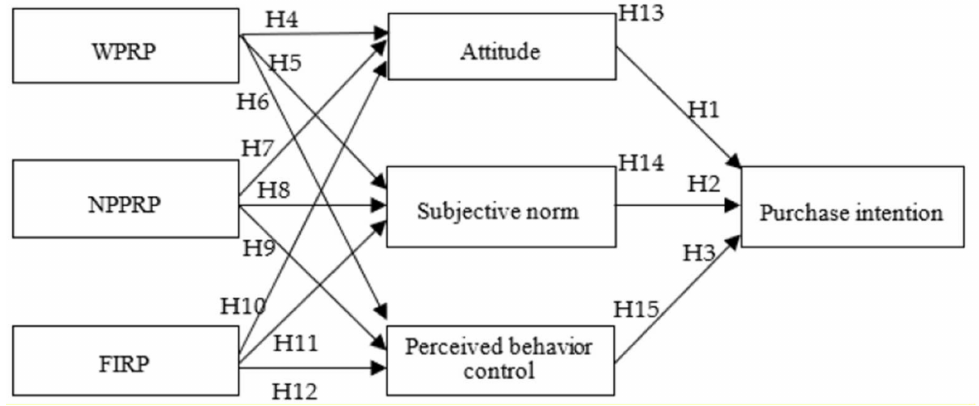
Figure 1. Research framework and hypothesis. Note: WPRP—water pollution risk